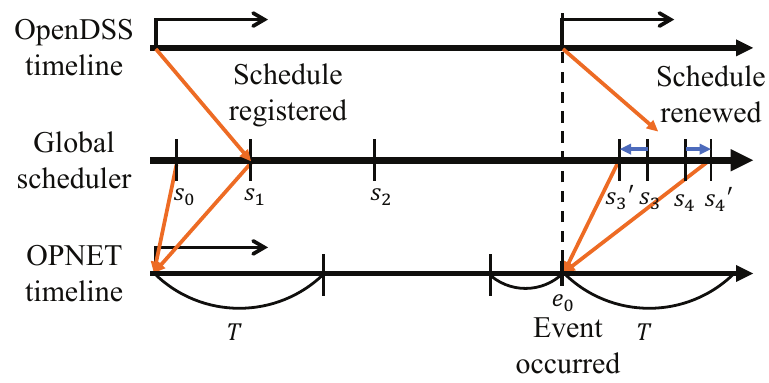
Figure 3. The example case of the scheduling